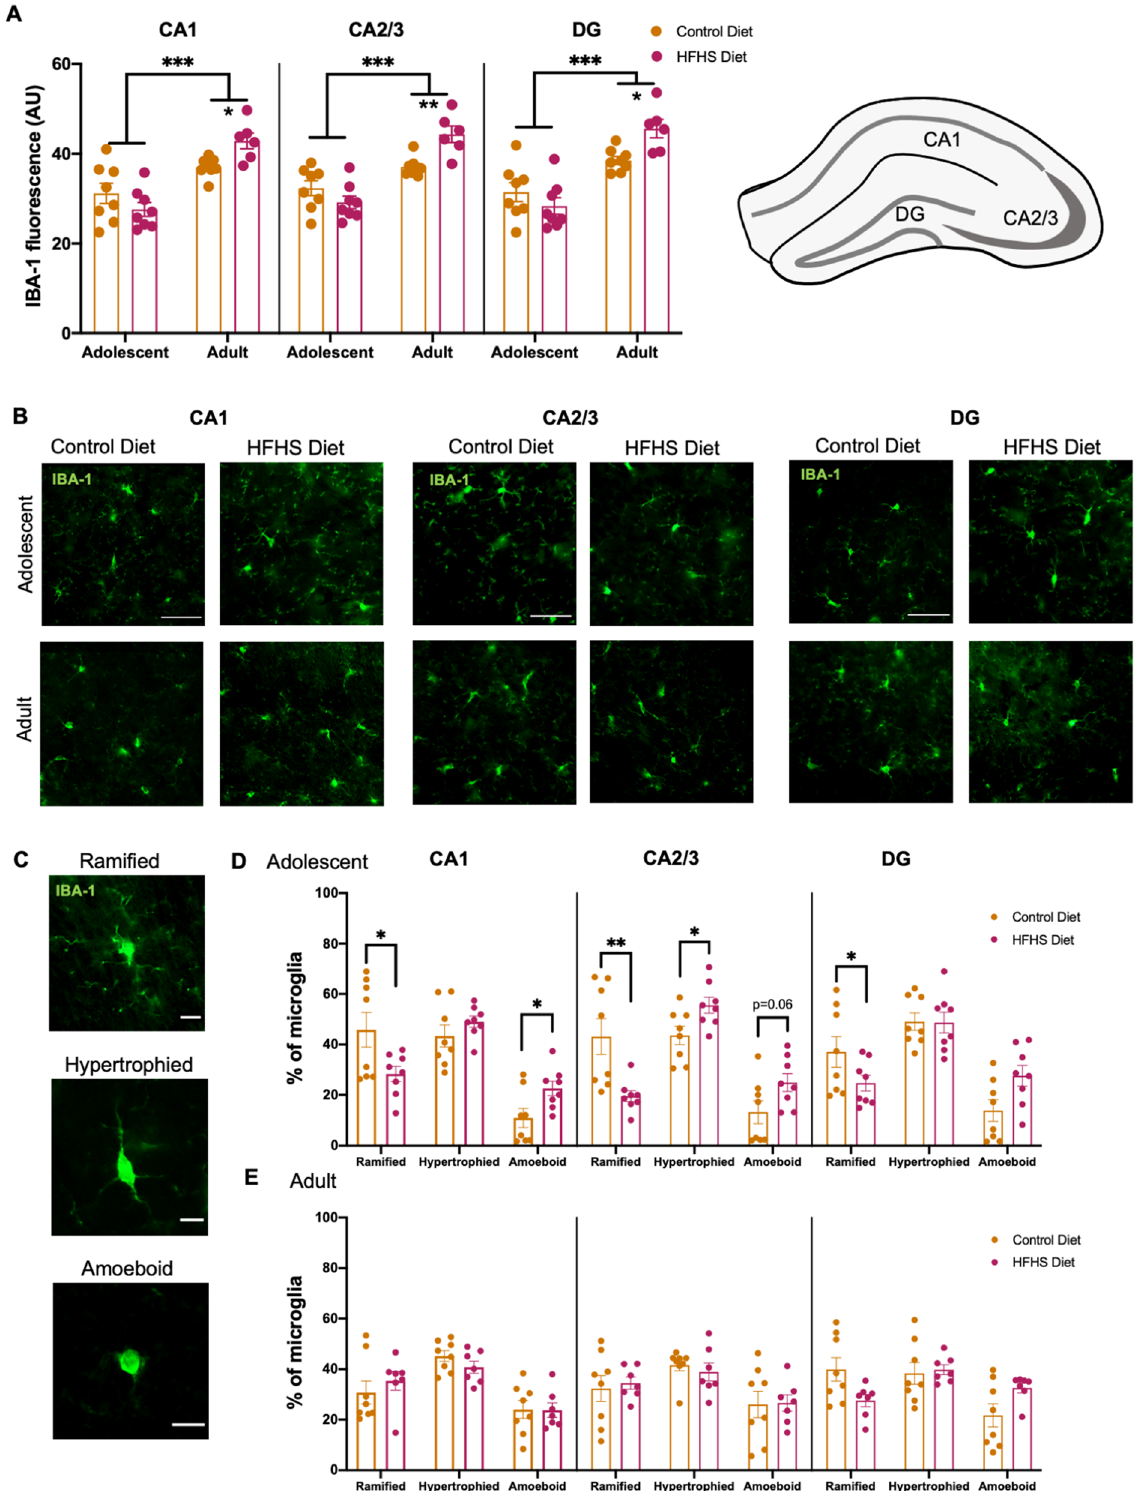
Figure 5. HFHS diet changes to hippocampal microglia density and morphology. Mice in the adult cohort had a significantly greater hippocampal IBA-1 fluorescence and adult mice that consumed the HFHS diet had significantly greater IBA-1 fluorescence compared to control diet mice ( A , B ). Mice that consumed HFHS diet across adolescence had proportionally fewer ramified ‘resting’ microglia and greater activated phenotypes (hypertrophied and amoeboid) in all three hippocampal subregions ( C , D ). In contrast, no diet-related changes ( C , E ) in microglia morphology were seen in mice that consumed HFHS diet as adults. Data were assessed using two-way ANOVAs and * p < 0.05, ** p < 0.01, *** p < 0.001. Representative photomicrographs were taken at 40X magnification (green— IBA-1 + microglia), scale bars show 50 μm for IBA-1 + density and 10 μm for microglia